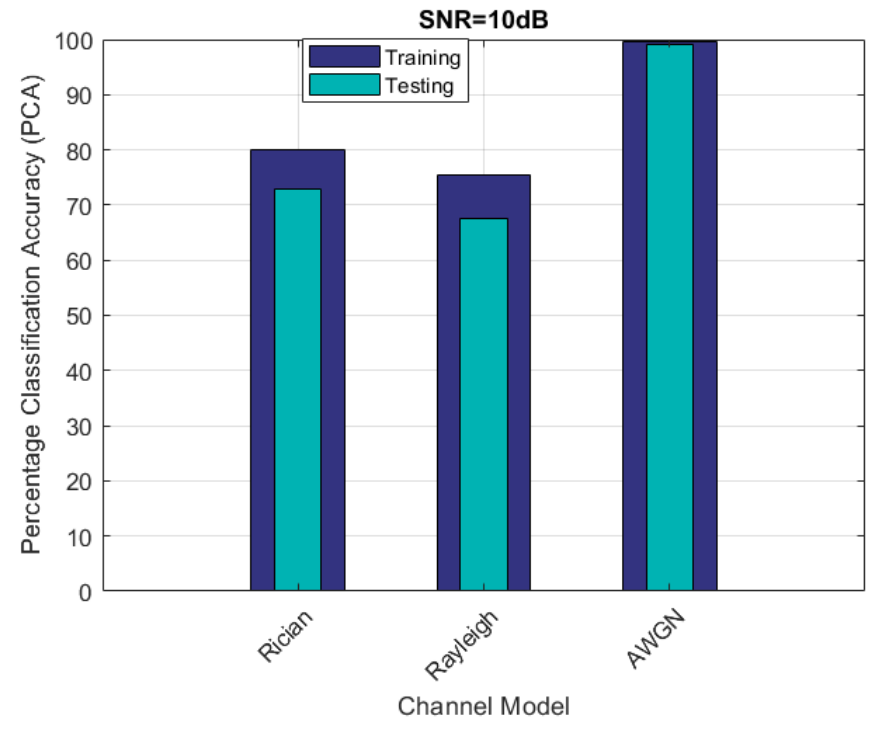
Figure 11. VB-DCNN Performance Analysis on Fading Channels (SNR = 10